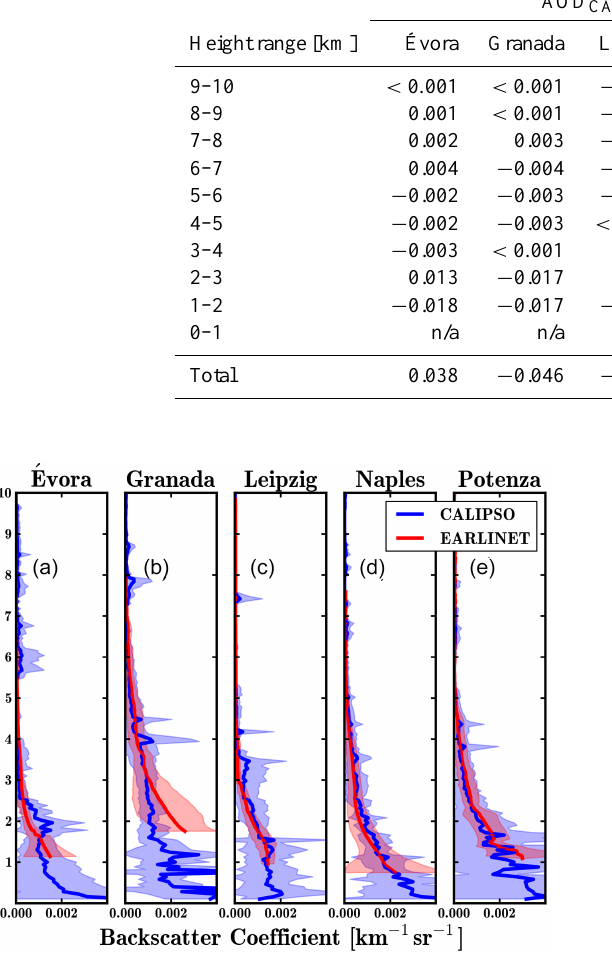
Figure 4. Backscatter coefficient at 532nm for CL3 ∗ (blue line) and for EARLINET (red line). From left to right: (a) Évora, (b) Granada, (c) Leipzig, (d) Naples, and (e) Potenza.